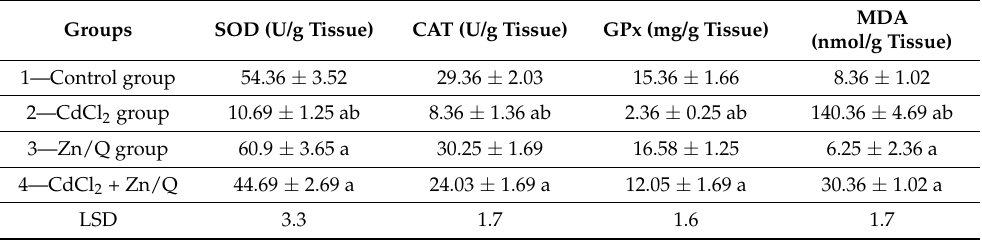
Table 3. Hepatic enzymes of treated groups with CdCl 2 , Q/Zn, and their combinations. Groups